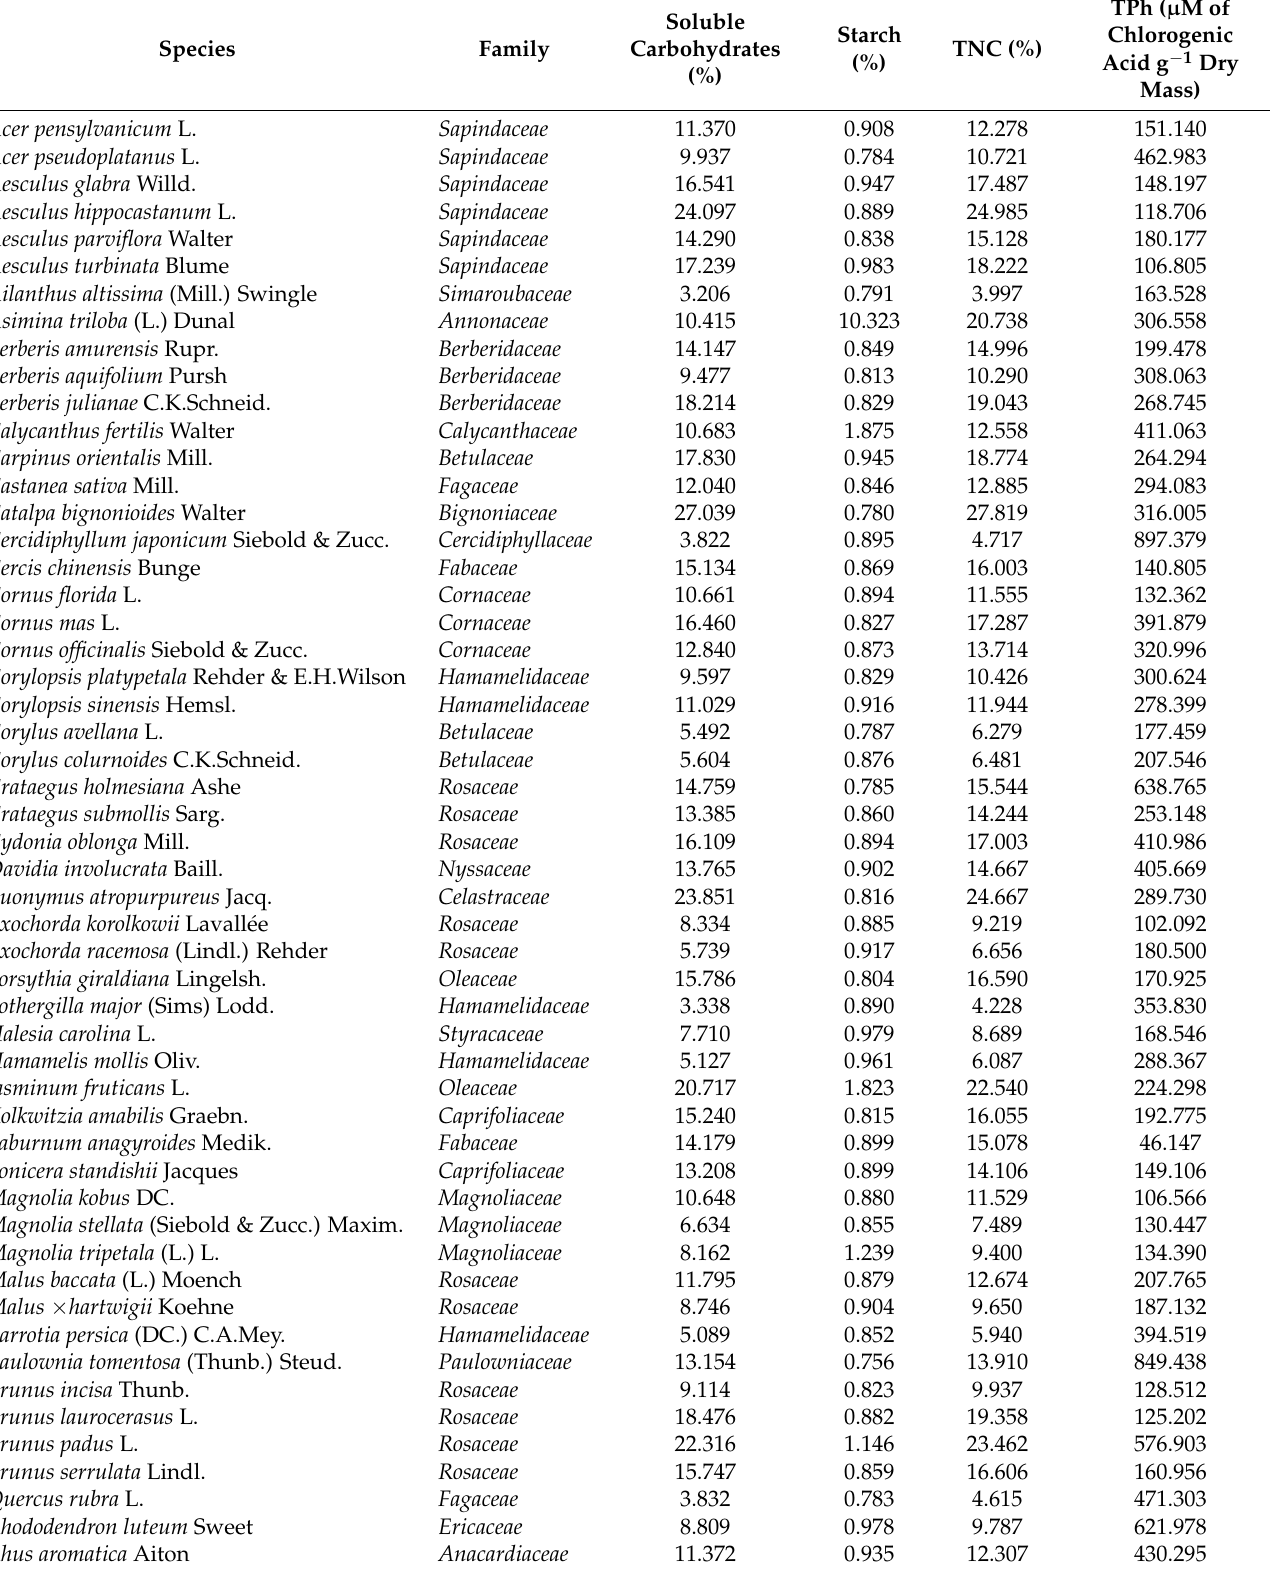
Table 1. Overview of the species studied and their mean soluble carbohydrates, starch, TNC, and TPh